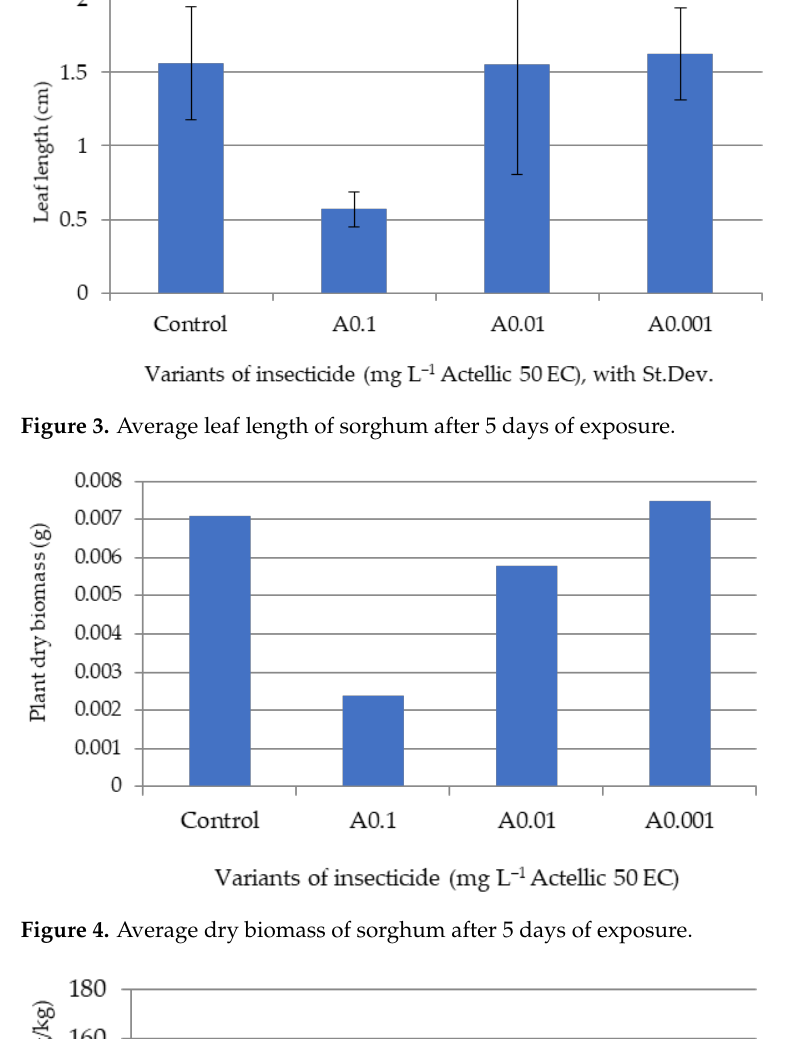
Figure 4. Average dry biomass of sorghum after 5 days of exposure.